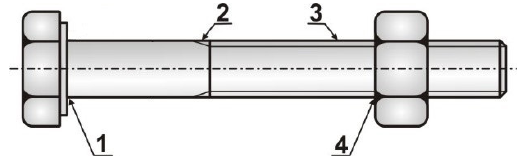
Figure 3. Notch locations on the bolt.